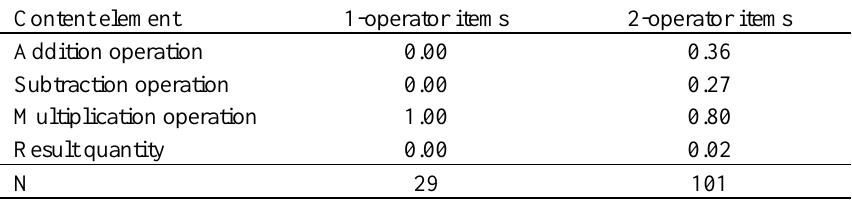
Proportion of No-story-action errors of each type